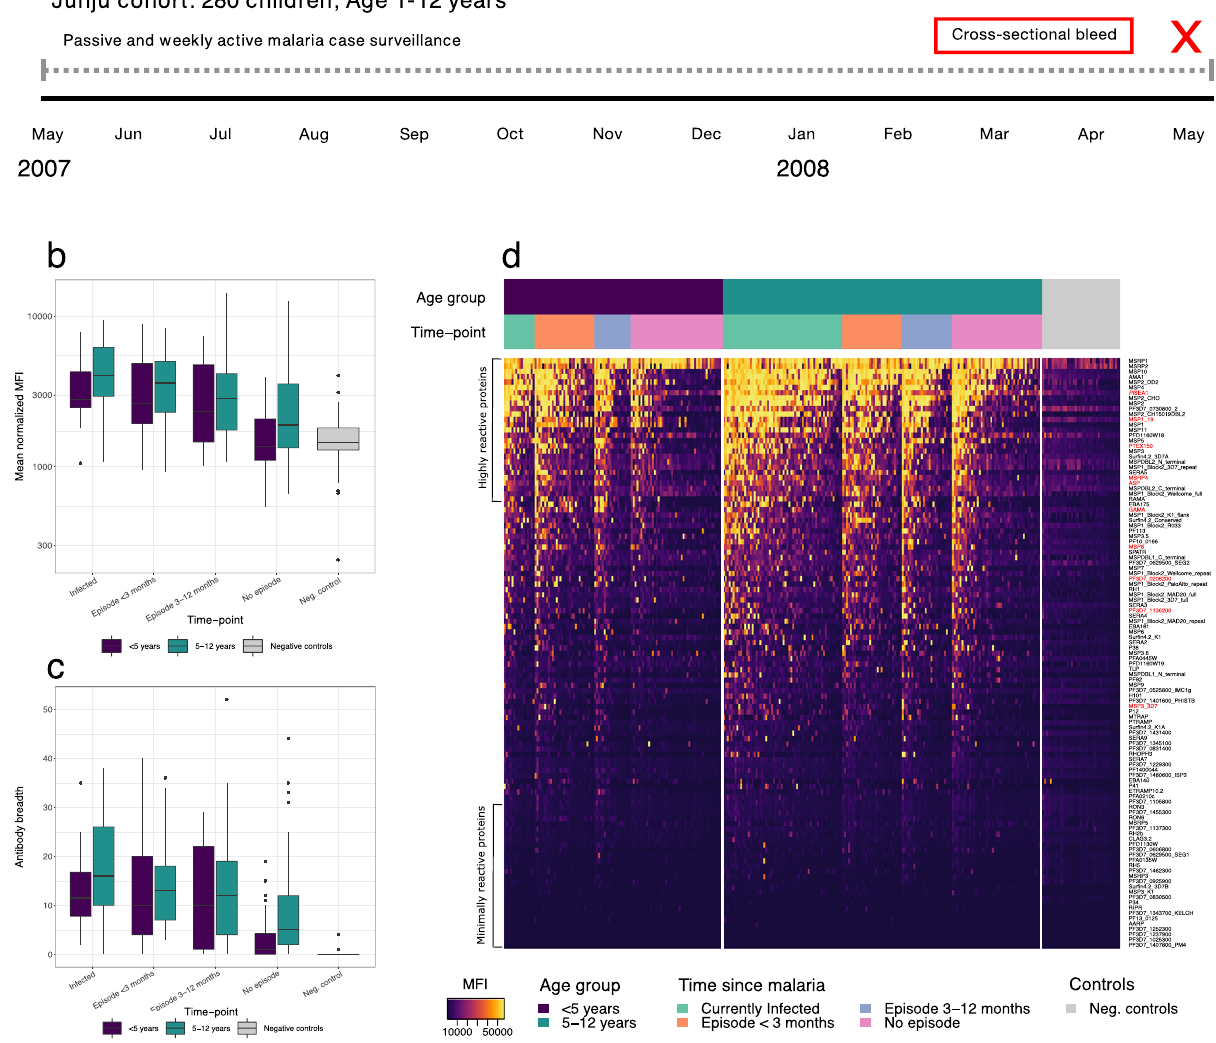
Fig. 8 Antibody patterns within the Junju cohort. a Schematic representation of the follow-up and sampling of the Junju cohort. 280 children (age 1 – 12 years) were monitored for 12 months using passive and weekly active malaria case surveillance. Samples were collected in a cross-sectional bleed at the end of the 12-month follow-up. b Box-plot of the overall magnitude of the antibody response to P. falciparum relative to current infection status and time since last documented clinical malaria episode (averaging signal intensities over all antigens for each individual) in individuals age <5 years (dark blue, 111 antibody responses ( a ) measured in 114 samples ( s ) from 114 unique study participants ( n )), age 5 – 12 years (green, a = 111, s = 166, n = 166) and in negative controls (light grey, a = 111, s = 42, n = 42). c Box-plot of the breadth of the response relative to current infection status and time since last documented clinical malaria episode in individuals age <5 years (dark blue, a = 111, s = 114, n = 114), age 5 – 12 years (green, a = 111, s = 166, n = 166) and in negative controls (light grey, a = 111, s = 42, n = 42). The breadth is expressed as the total number of antigens (out of the 111) to which the individual responds. The centres of boxes correspond to the median. The lower and upper hinges of boxes correspond to the fi rst and third quartiles of the data. The upper and lower whiskers extend from the hinges to the largest and smallest values, respectively, no further than 1.5 * the interquartile range from the hinges. Data beyond the end of the whiskers are plotted individually. d A heat map of the normalised median fl uorescent intensity (MFI) of the antibody response to each of the 111 antigens within the Junju cohort. Rows correspond to individual antigens while columns correspond to individual samples. Antigens are sorted from top to bottom by decreasing average normalised MFI across all samples. Samples are sorted fi rst by age, second by time since last clinical malaria episode and third by average normalised MFI across all